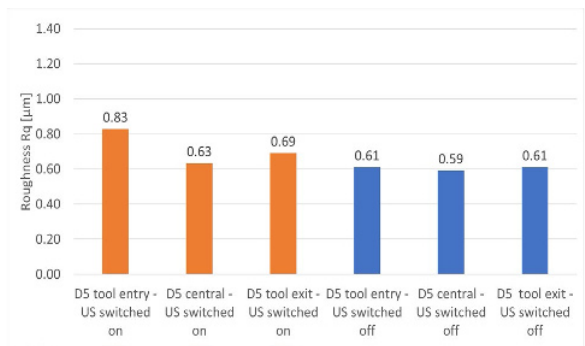
Fig. 2. Roughness results for the 5 mm diameter holes as a function of ultrasonics switched on / off